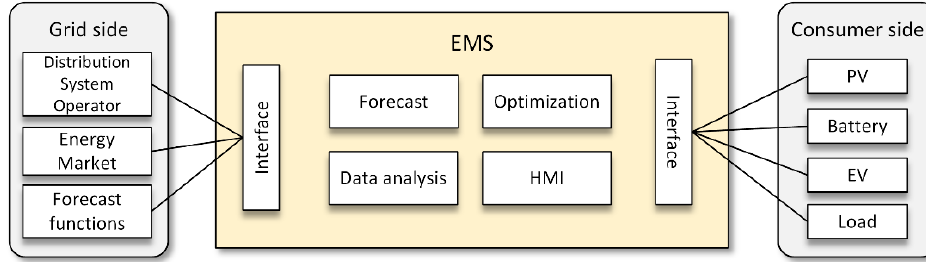
Figure 4. An illustration of a hybrid PV–battery